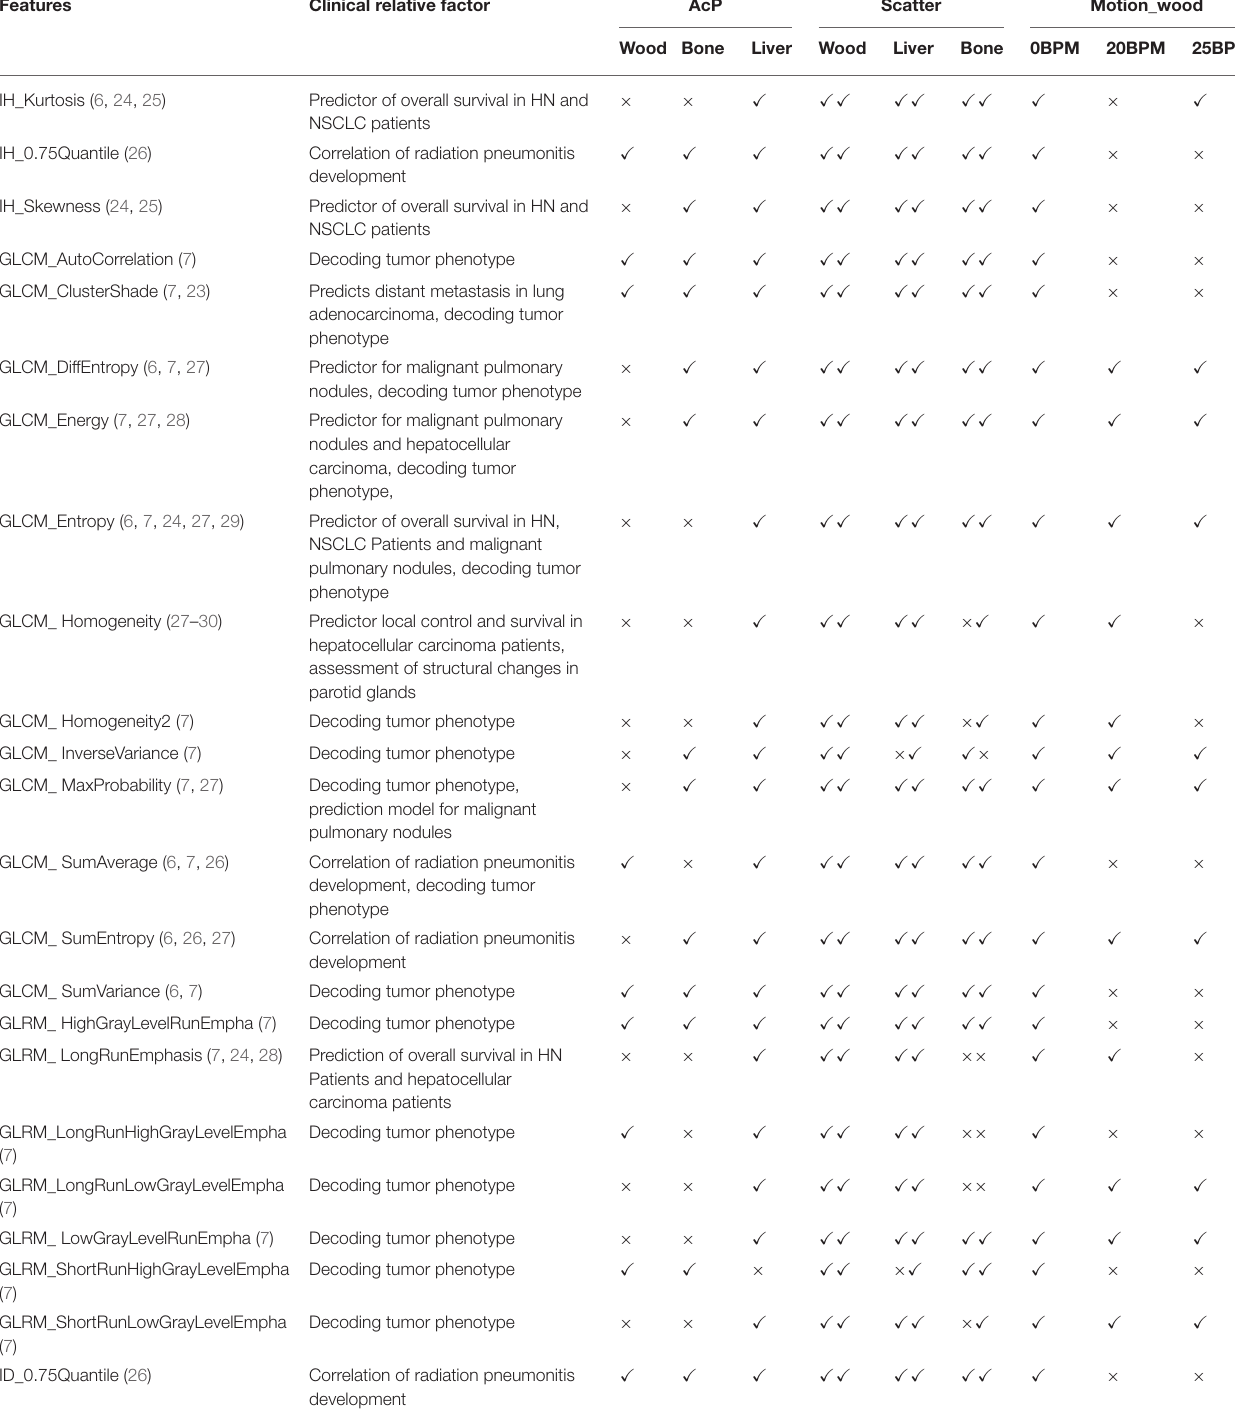
TABLE 1 | Reproducibilities of clinically significant